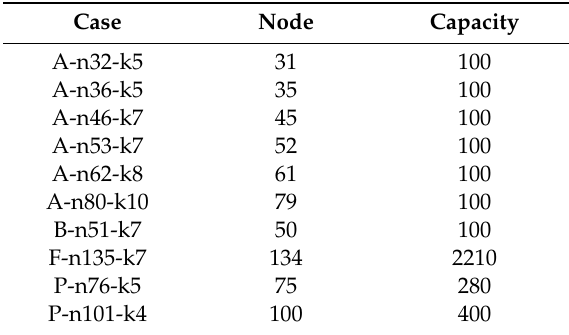
Table 3. Data about the test instances.